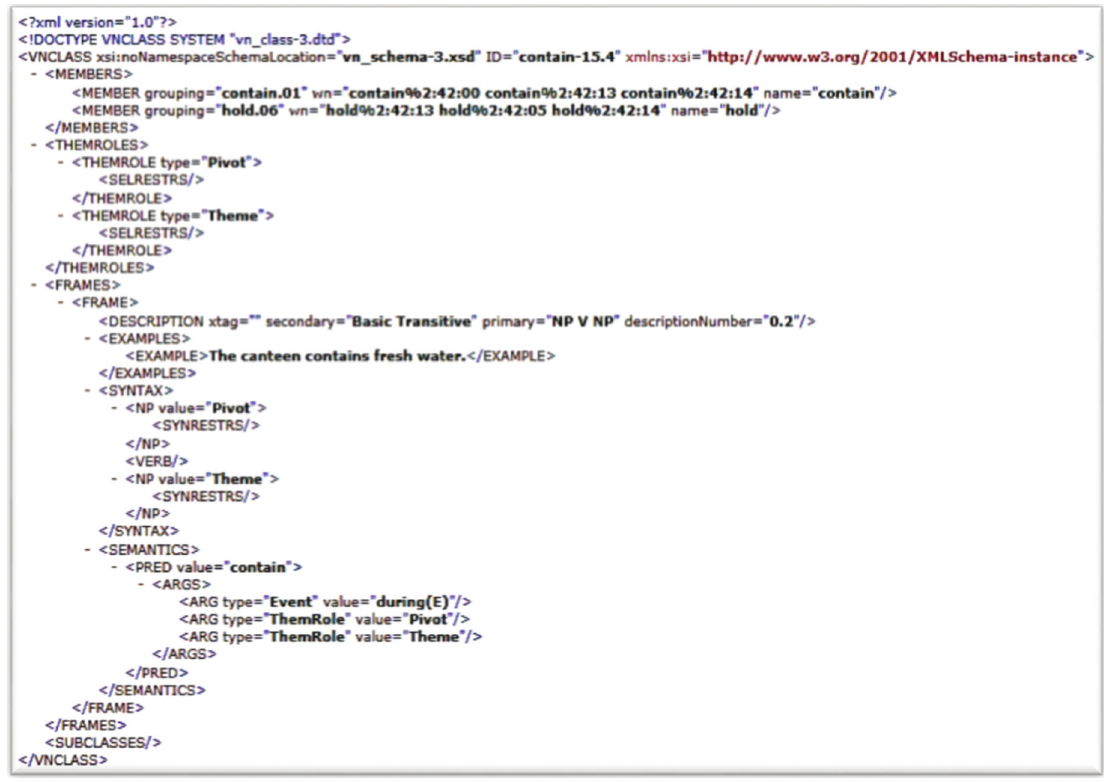
Figure 9: XML File for a Sample VN Verb Entry